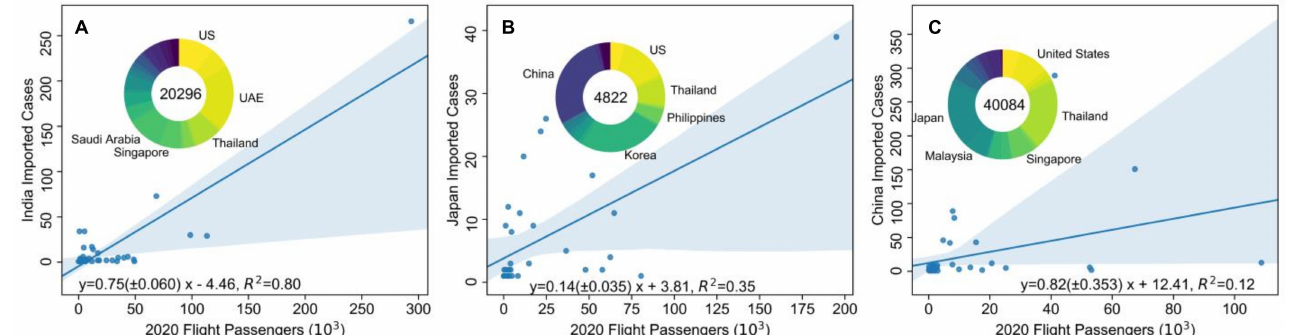
Figure 4. Imported cases in relation to inbound flight passengers in India ( A ), Japan ( B ) and China ( C ). Donut chart shows the estimated number of cases prevented by limiting inter-country mobility locally as compared with airline passengers in 2019. Values in the center of the chart indicate the possible number of confirmed imported cases that were prevented. Annotated countries are the top five greatest contributors to imported cases in each of the three countries. Data with country name are listed in Table